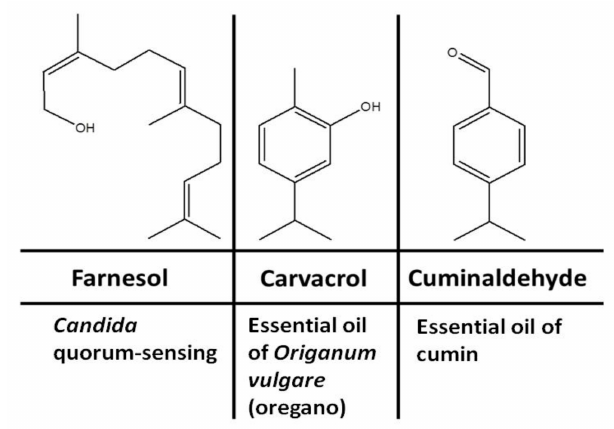
Figure 1. Structures and possible sources of terpenoidal